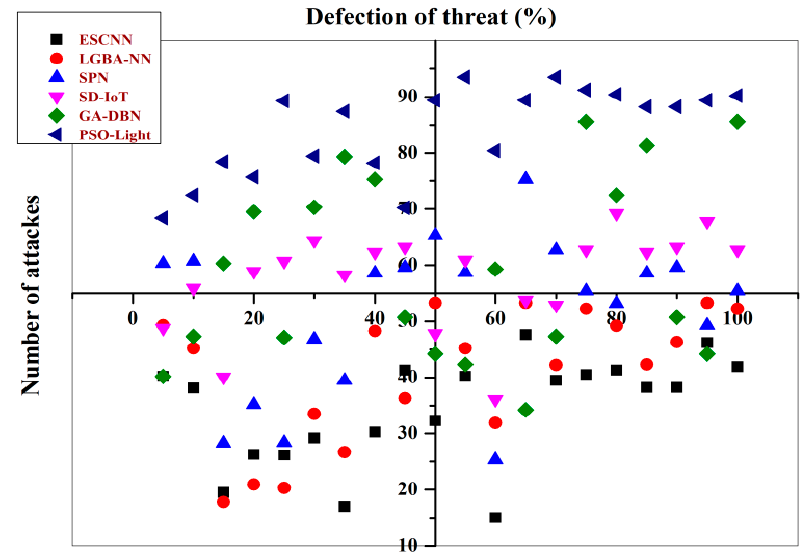
Figure 8. Threat defections on